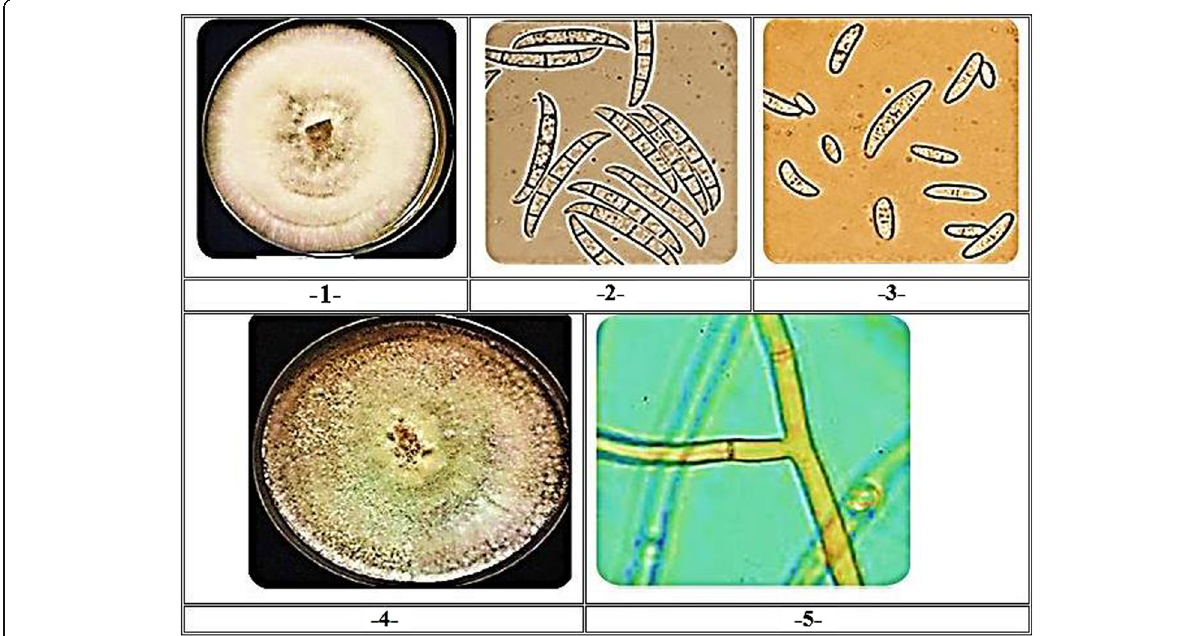
Fig. 1 Morphological characteristics of mycelial growth ( 1 ), macroconidia ( 2 ), and microconidia ( 3 ) of F. solani and mycelial growth of R. solani ( 4 and 5 ) on